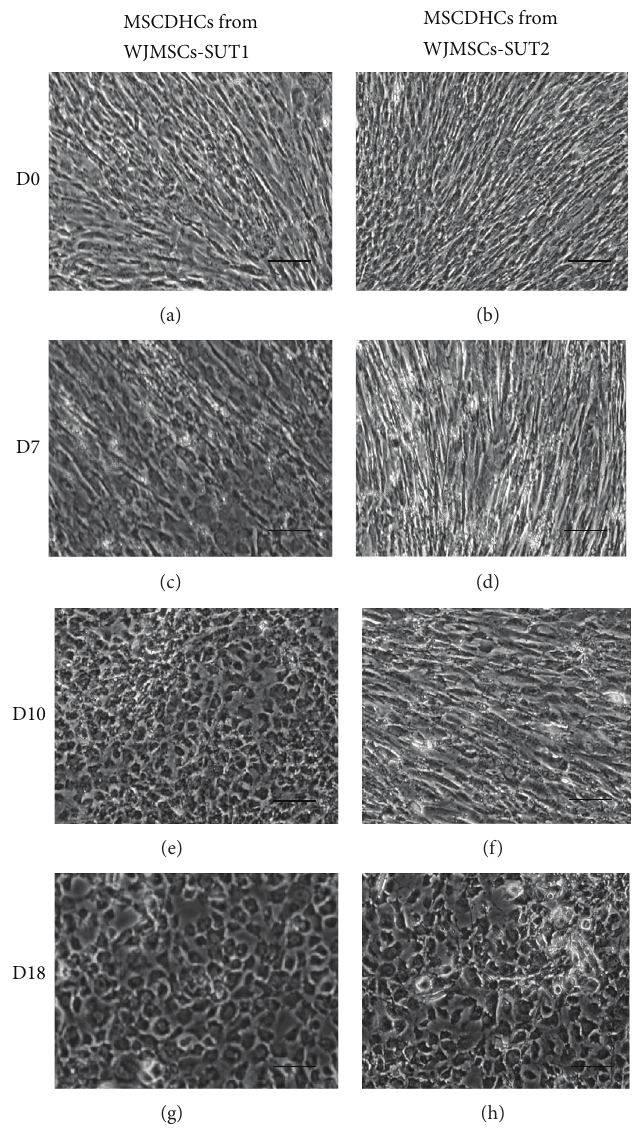
Figure 2: Hepatocyte-like cells feature of the differentiated cells during hepatogenic induction for 18 days. Morphological changing of MSCDHCs generated from WJMSCs-SUT1 ((a), (c), (e), and (g)) and WJMSCs-SUT2 ((b), (d), (f), and (h)) were observed following the differentiation period. Original magnifications: ×100 for all pictures. Bars indicate 100 𝜇